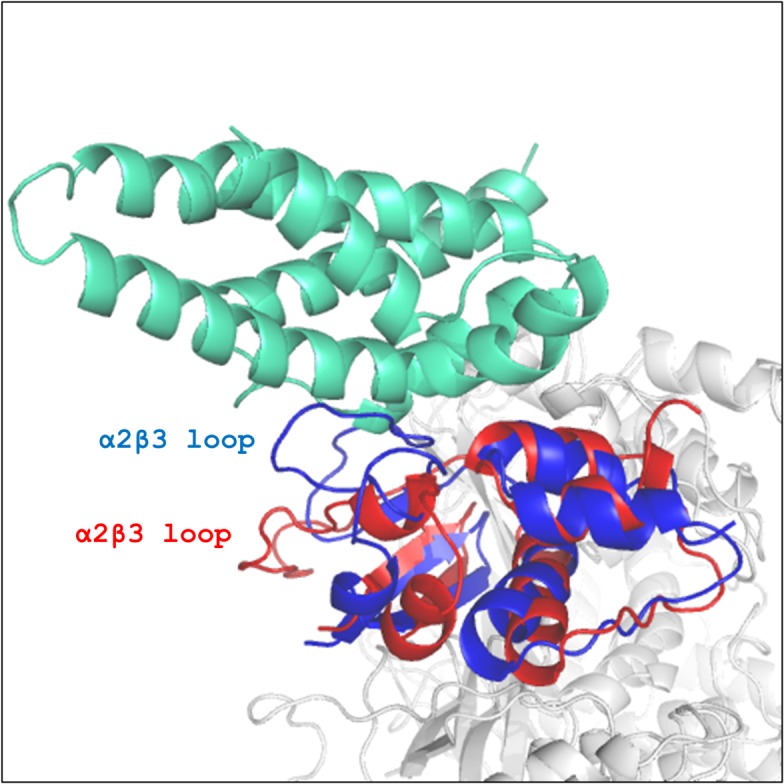
Cul3 binding site in the average MD structures of KCTD11BTB and CHIM11/12BTB.KCTD11BTB, CHIM11/12BTB, Cul3NTD are represented in blue, red and green, respectively. For clarity, a single chain of the tetramers is highlighted.